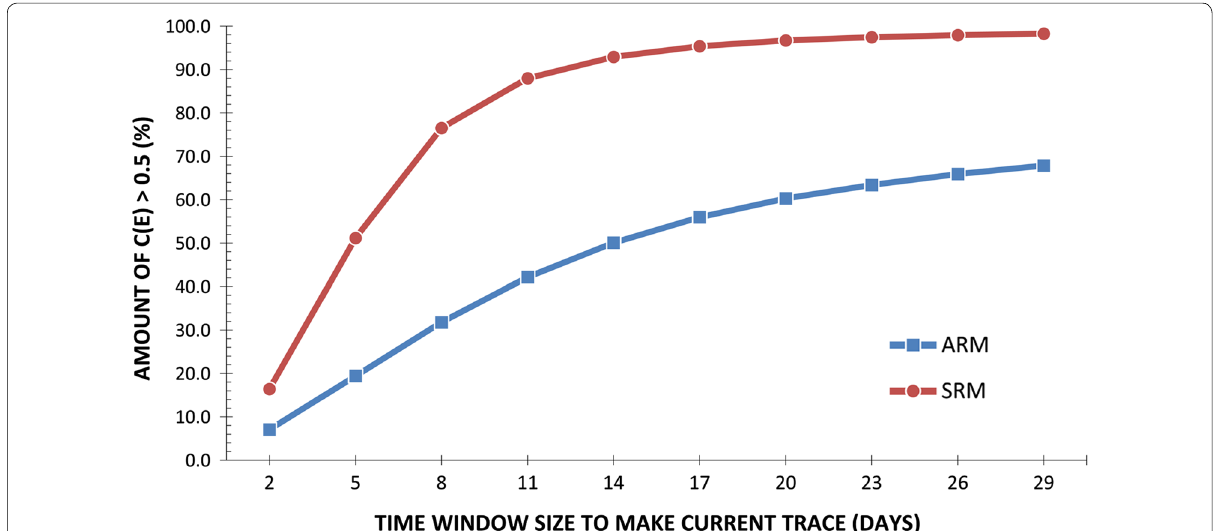
Fig. 6 The result of stability evaluation for the ARM and SRM in Kyushu. The study period includes the 2016 Kumamoto earthquake. The time windows chosen to define the current trace are 17 and 11 days for the ARM and SRM, respectively